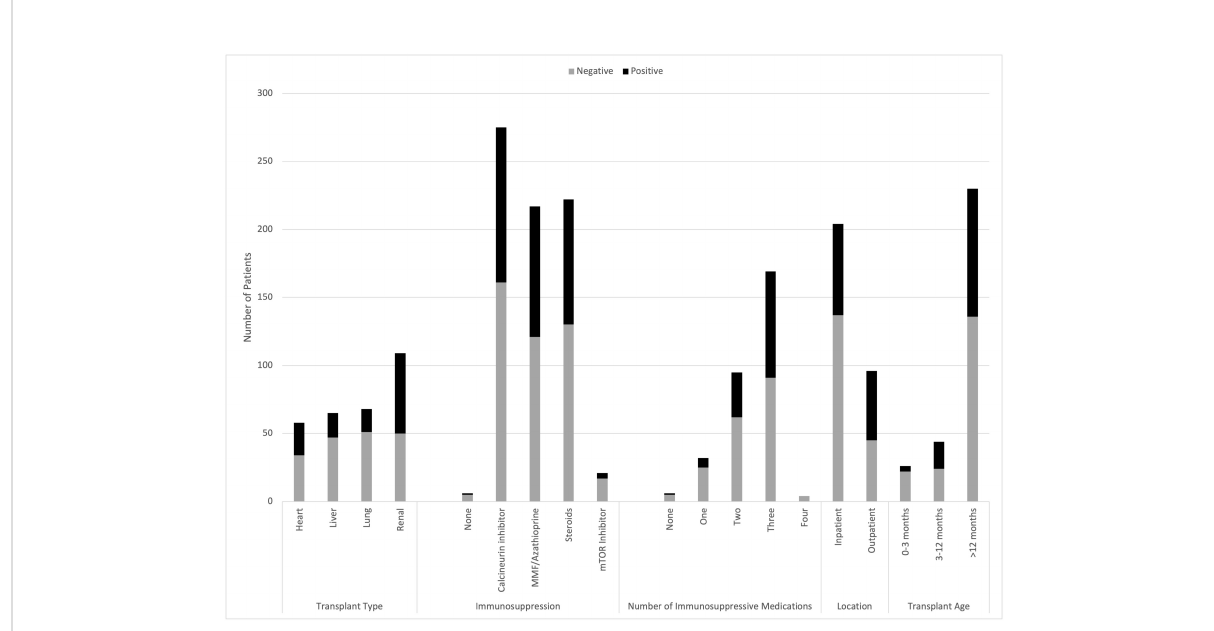
FIGURE 1 Prevalence of Infectious Diarrhea Varies Based on Transplant Type, Immunosuppression, Location, and Transplant